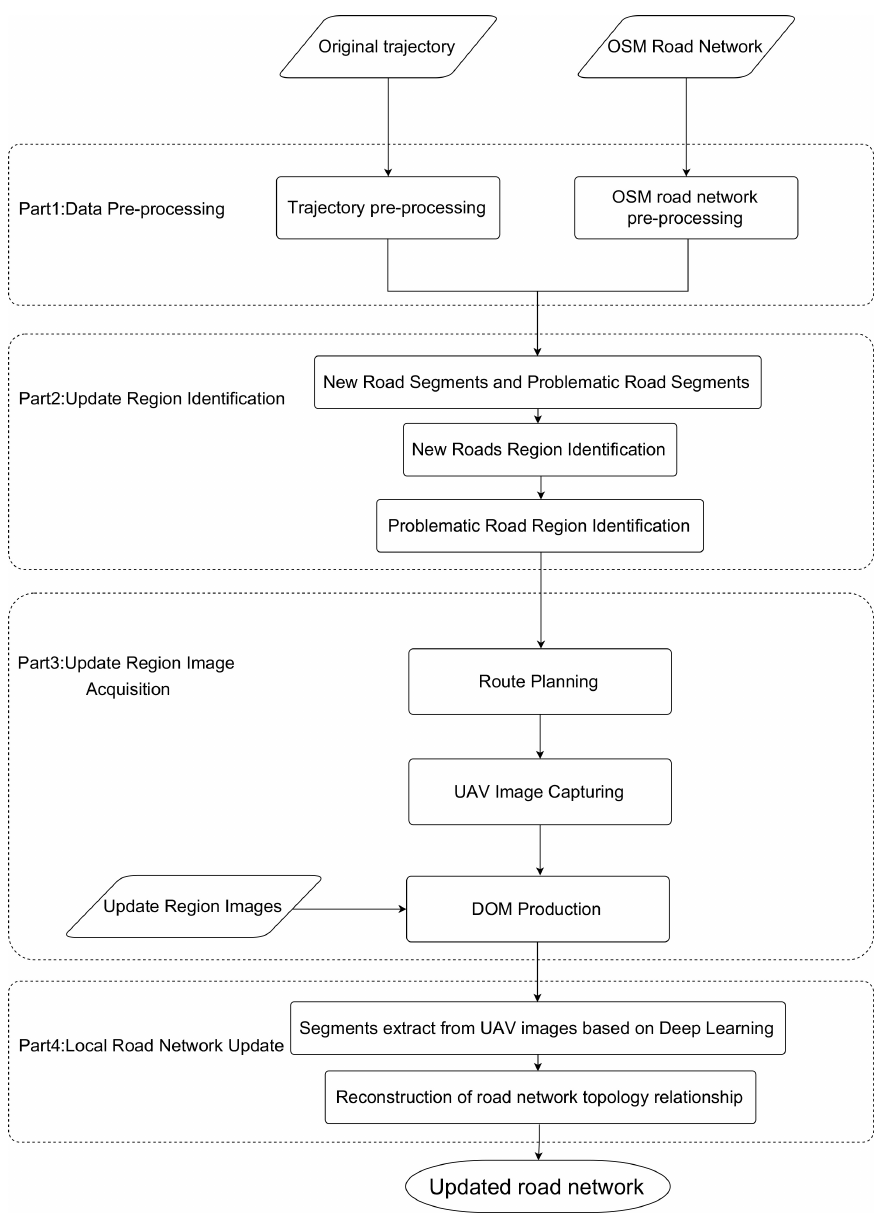
Figure 1. Workflow of the proposed